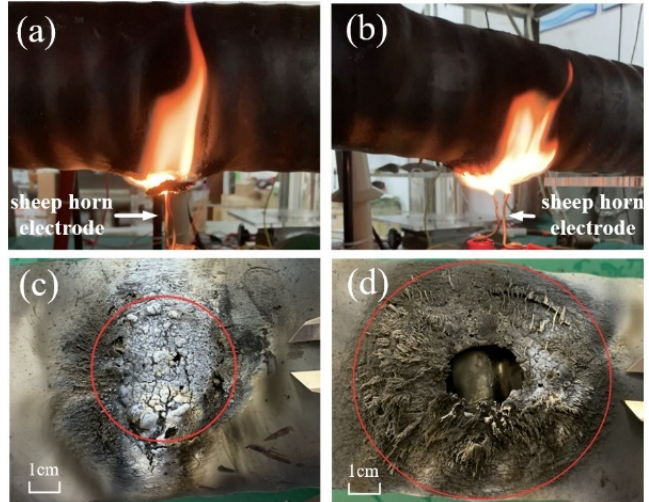
Figure 6. The photos of the cable burning and cable damage with different arc sizes. The distances between the tips of electrodes are 1.5 cm for ( a , c ) and 2.5 cm for ( b , d ).